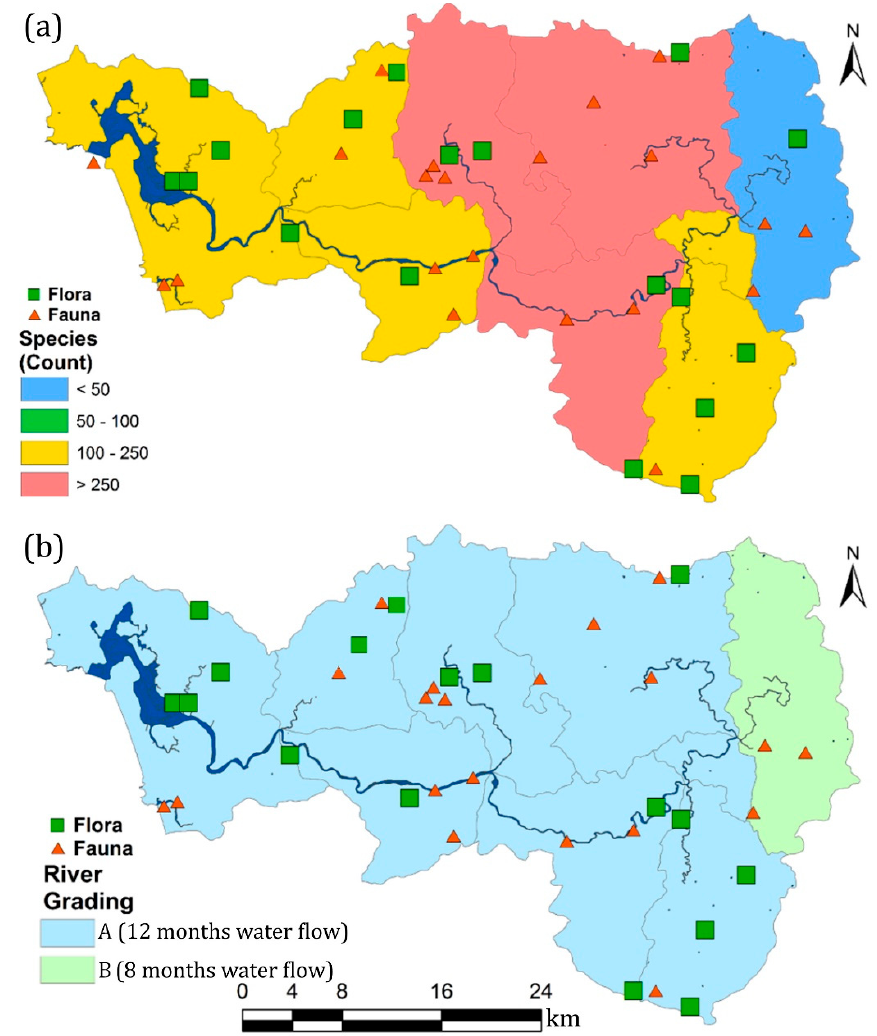
Figure 6. ( a ) Species distribution, ( b ) species distribution with the water availability—Ecology and hydrologic regime linkages in the Aghanashini River basin.